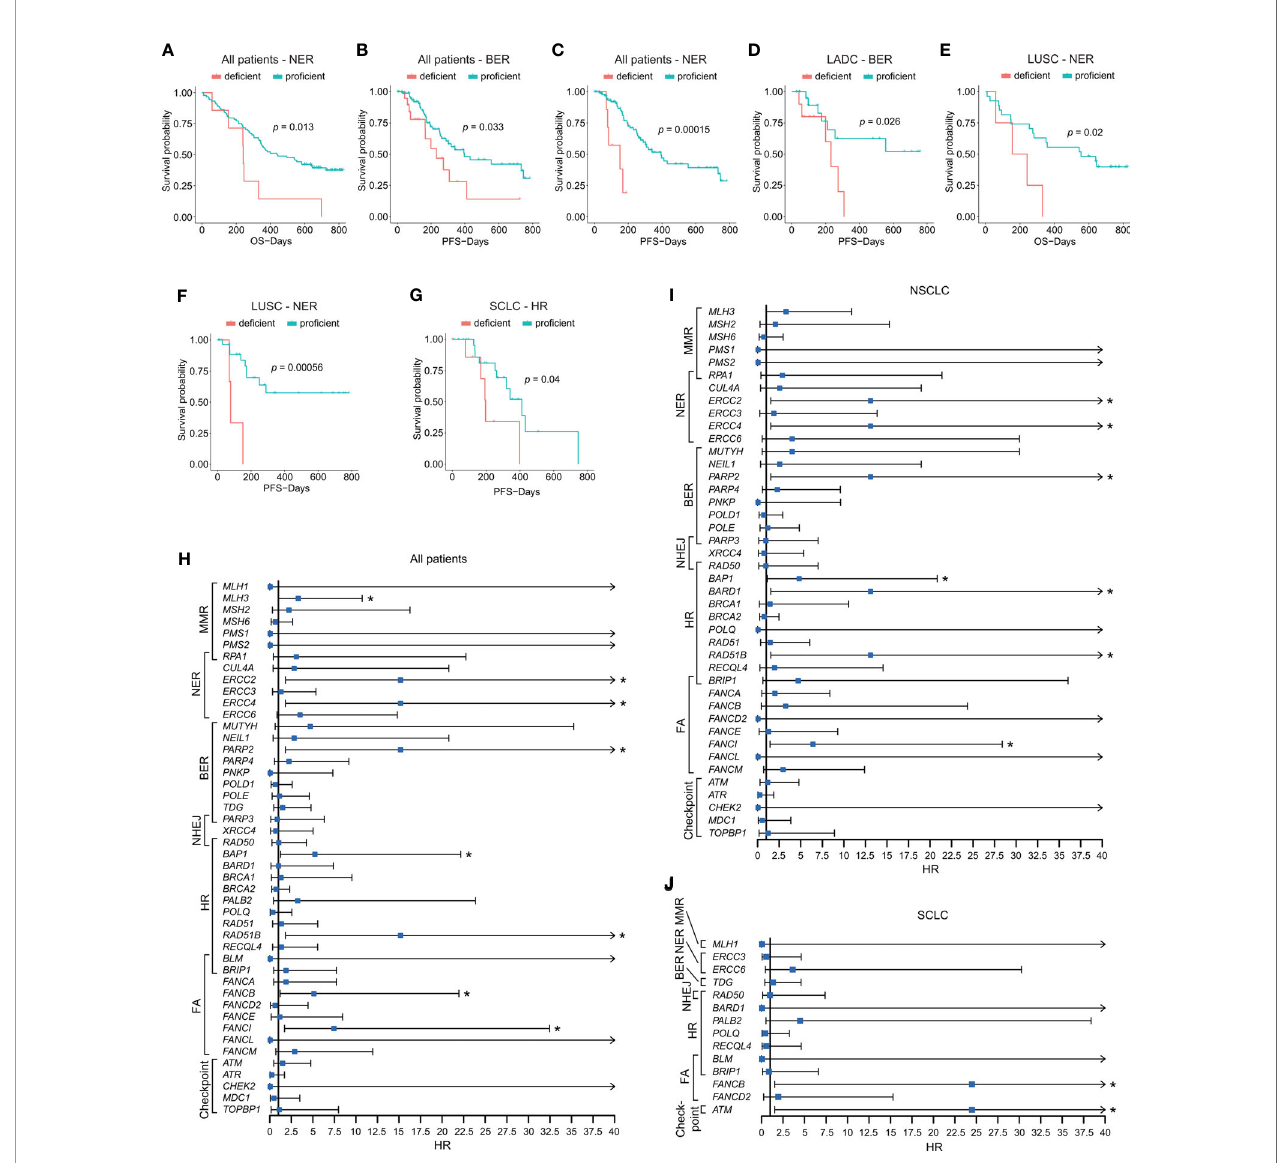
FIGURE 4 | Impacts of alterations of DDR pathways and single DDR genes on patients ’ prognosis. (A – C) Survival analyses of DDR gene alterations on PFS and OS in NER and BER pathways in all patients. (D) Survival analysis of BER alteration on PFS in LADC cohort. (E) Survival analysis of NER alteration on OS in LUSC cohort. (F) Survival analysis of NER alteration on PFS in LUSC cohort. (G) Survival analysis of HR alteration on PFS in SCLC cohort. (H) Impacts of somatic alterations in single-gene level on OS in all patients. (I) Impacts of somatic alterations in single-gene level on OS in NSCLC patients. (J) Impacts of somatic alterations in single-gene level on OS in SCLC patients. The Kaplan – Meier and Cox regression analysis were performed. * p < 0.05. The “ checkpoint ” referred to “ cell cycle checkpoint. ”